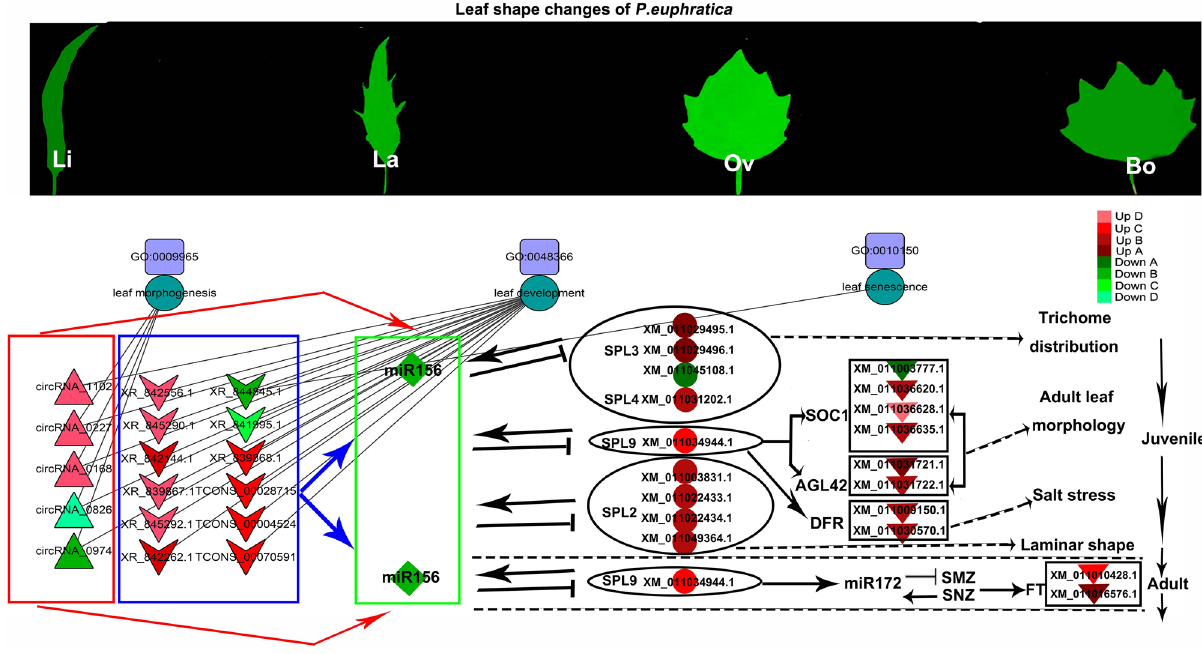
Figure 9. The interplay of SPL TFs and miRNAs in P. hl. Lines with arrowheads represent positive regulation, whereas lines with a bar at the end represent negative regulation. Triangles, Vs, rectangles, ellipses, and inverted triangles represent circRNAs, lncRNAs, GO IDs, biological processes, and target genes, respectively. As indicated in the right, red shows up-regulated expression, among them twofold ≥ Up A > onefold, fivefold ≥ Up B > twofold, tenfold ≥ Up C > fivefold, Up D > tenfold; green indicates down-regulated expression, among them twofold ≥ Down A > onefold, fivefold ≥ Down B > twofold, tenfold ≥ Down C > fivefold, Down D > tenfold. This figure was generated by Cytoscape 3.8.2 (https:// cytos cape. org/) and